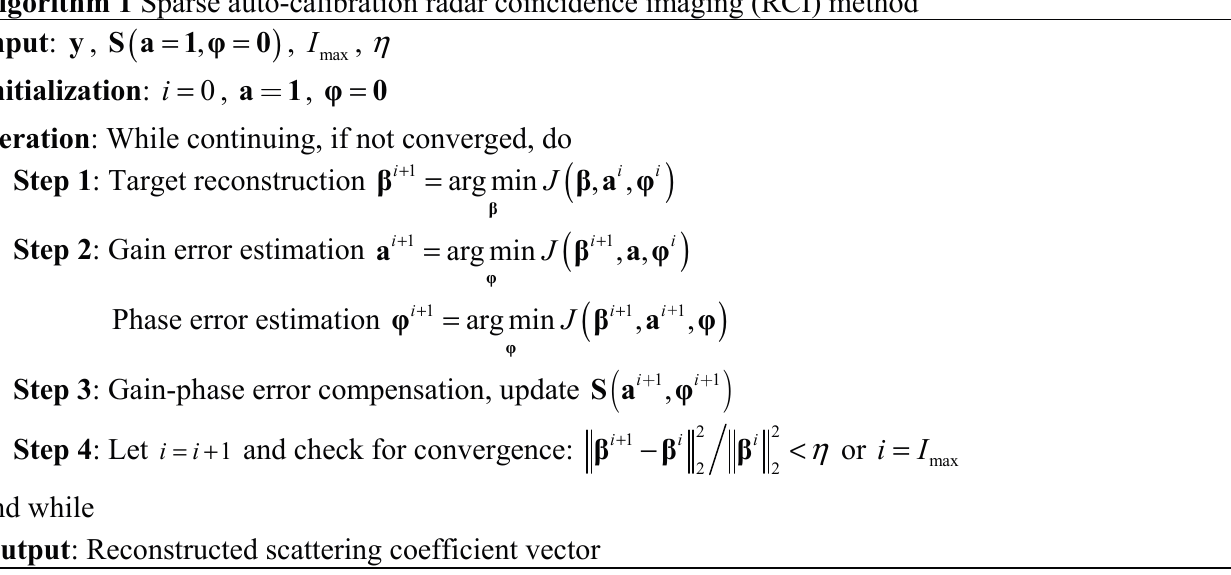
Algorithm 1 Sparse auto-calibration radar coincidence imaging (RCI)